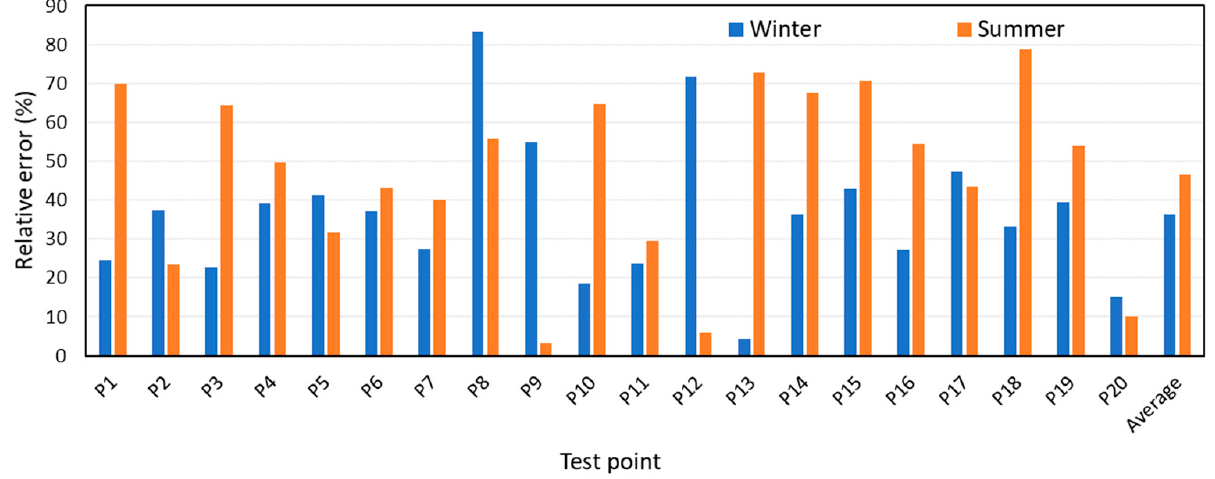
Figure 15. Relative errors of the wind speed data.